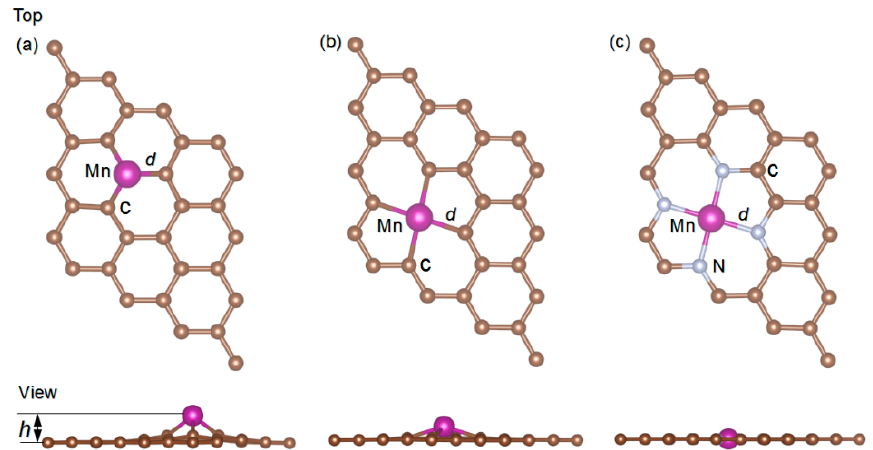
Figure 1. Optimized structures of ( a ) MnSV-GN, ( b ) MnDV-GN and ( c ) MnN 4 -GN, the bond lengths (d, Å), adsorption height of Mn atom (h, Å).